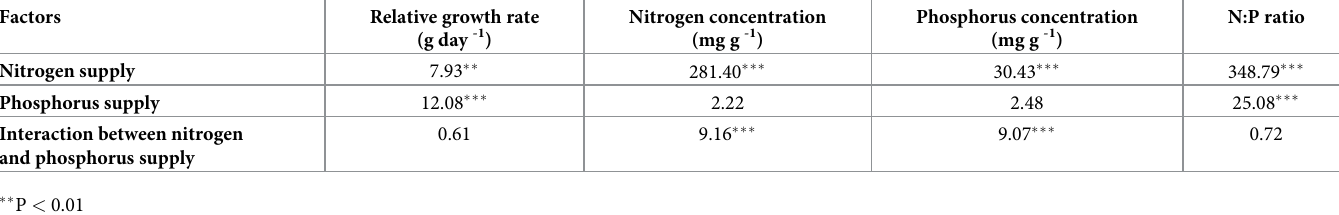
Table 3. Effects ( F value) of nitrogen and phosphorus supply and their interaction on relative growth rate of H . vulgaris , nitrogen and phosphorus concentrations, N: P ratio in its leaf.